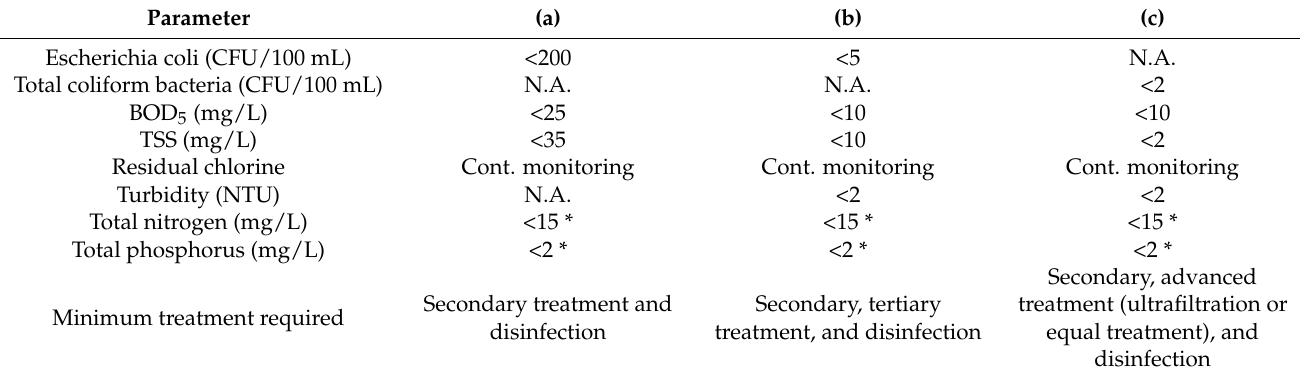
Table 1. Greek legislation treated water quality criteria for (a) restricted irrigation, single use industrial cooling water, and enrichment of underground aquifers for nonpotable uses, (b) unrestricted irrigation and industrial use, except for single use cooling water, (c) urban and suburban reuse and the enrichment of aquifers with boreholes. Parameter (a) (b)